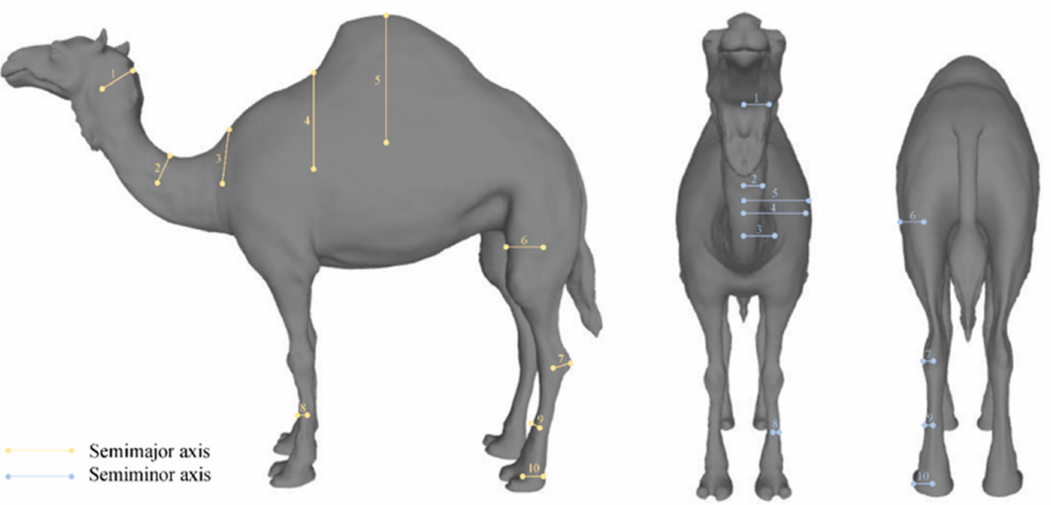
Figure 4. Schematic representation of semimajor and semiminor axis digital imaging collection references for perimeters and girths computation in Canarian camels. (1) Neck girth: cranial third; (2) Neck girth: middle third; (3) Neck girth: caudal third; (4) Heart girth; (5) Hump girth; (6) Thigh perimeter; (7) Hock perimeter; (8) Fore cannon bone perimeter; (9) Rear cannon bone perimeter and (10) Foot